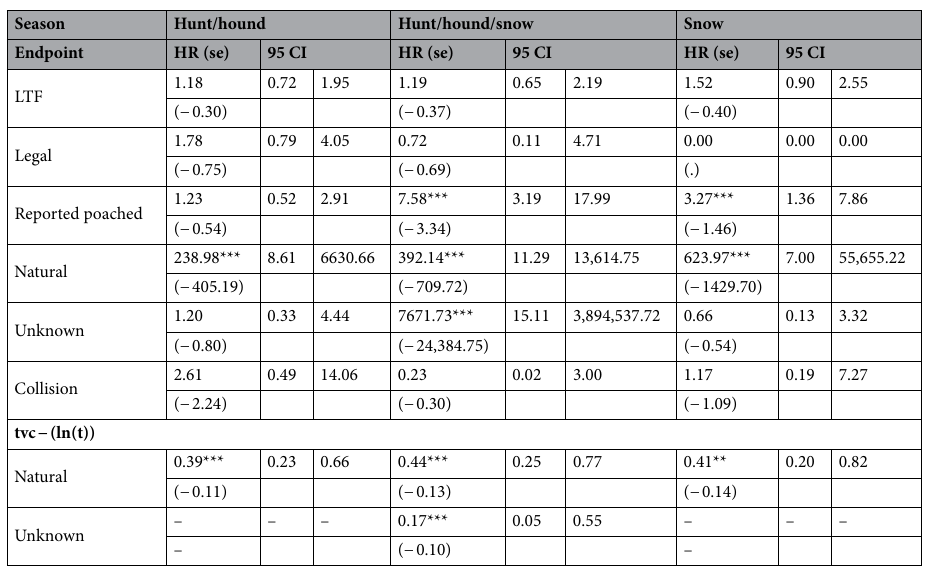
Table 1. Hazard ratio (HR) point estimates from the stratified (by endpoint and protection period) joint Cox Model 3 (our best performing model, see Supplementary Material Tables 3–7 for model statistics, diagnostics and other models) for n = 495 monitored adult wolves, by endpoint and season (LTF = ‘lost to follow-up’, defined in Methods). We present HRs and compatibility intervals (95 CI) for all endpoint-season interactions relative to a baseline season. *p < 0.10, **p < 0.05, ***p <